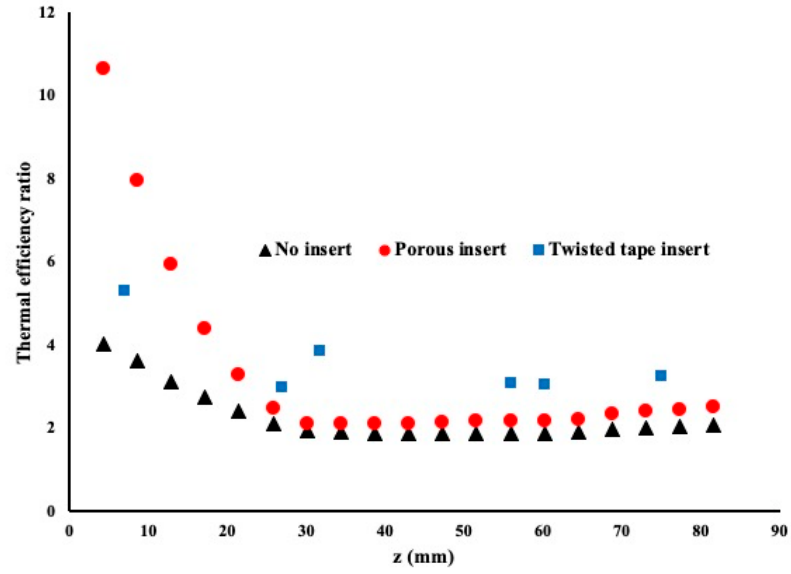
Figure 9. Thermal efficiency ratio for different configurations.